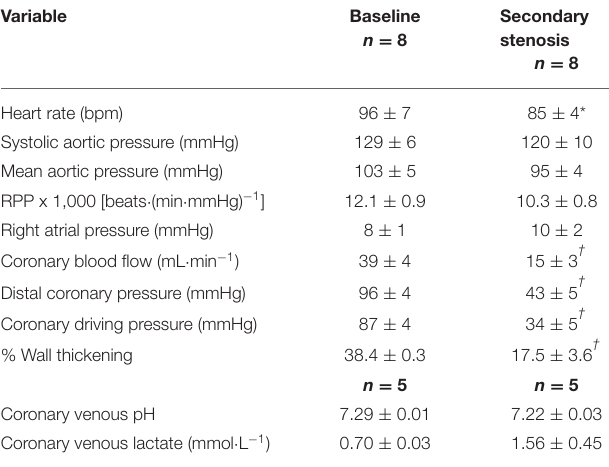
TABLE 2 | Secondary stenosis results (mean ±